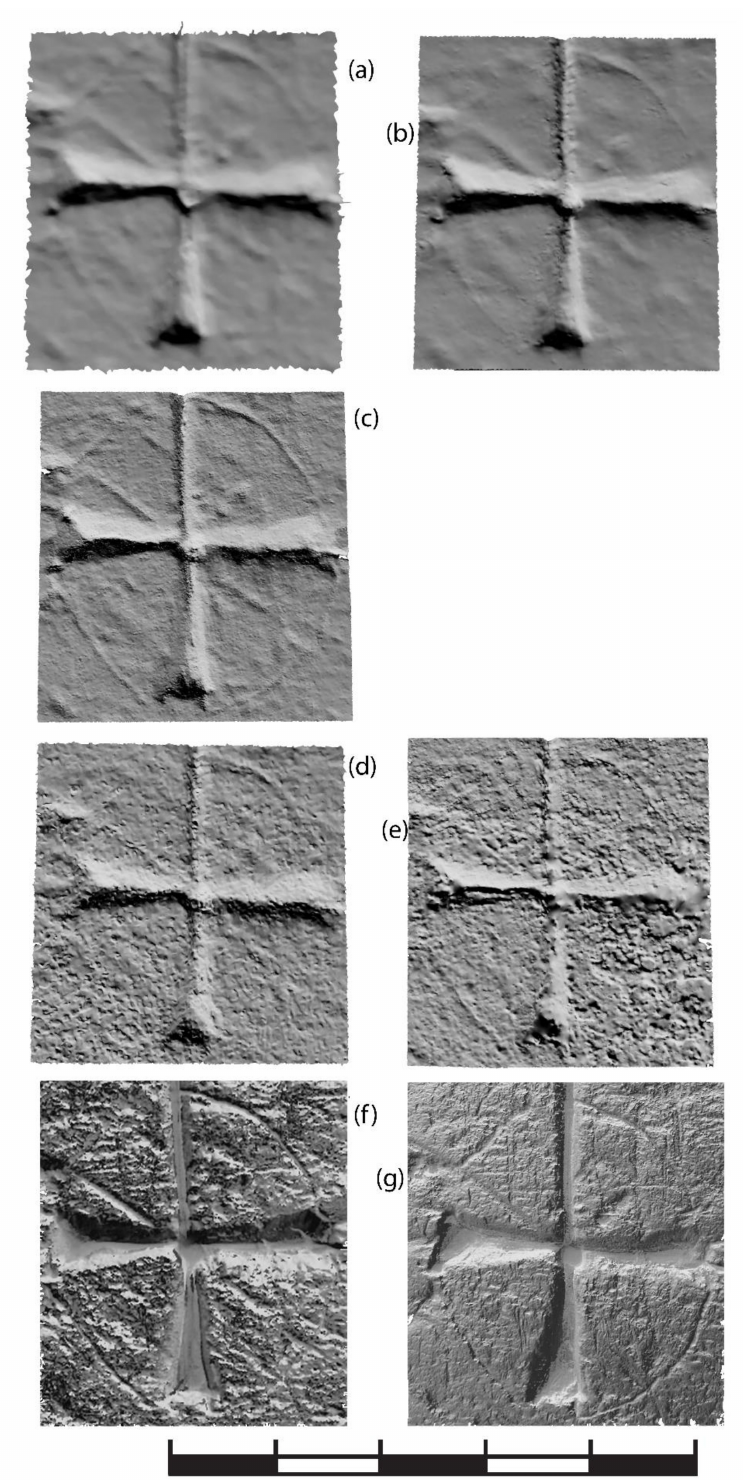
Figure 5. Detail from Surface A. ( a ) IBM-MetaShape (MS); ( b ) IBM-RC; ( c ) Combo 1-RC; ( d ) Combo 2-MS; ( e ) Combo 2-RC; ( f ) H-RTI; and ( g ) RL-RTI. The RTI models are the most detailed, while the Combo 1 model is the most detailed of the 3D models. The Combo 2 models are the least detailed and have more noise than the other 3D models. The scale shown is 5 cm. All images are available in full resolution